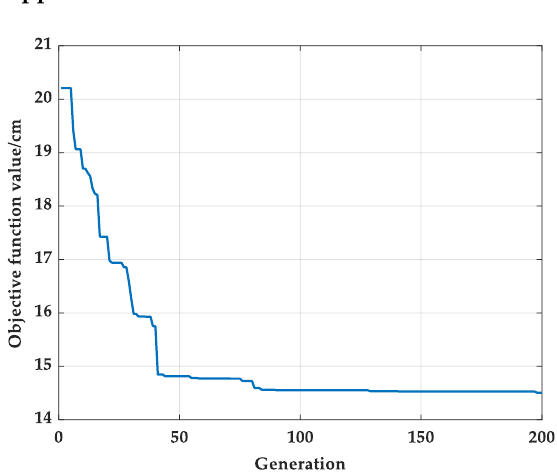
Figure A1. Errors evolution curve without signal interference.